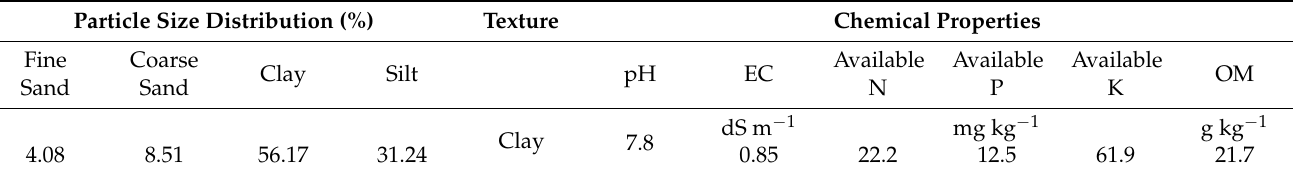
Table 1. Physical and chemical properties of the soil used in the two growing seasons. Particle Size Distribution (%) Texture Chemical